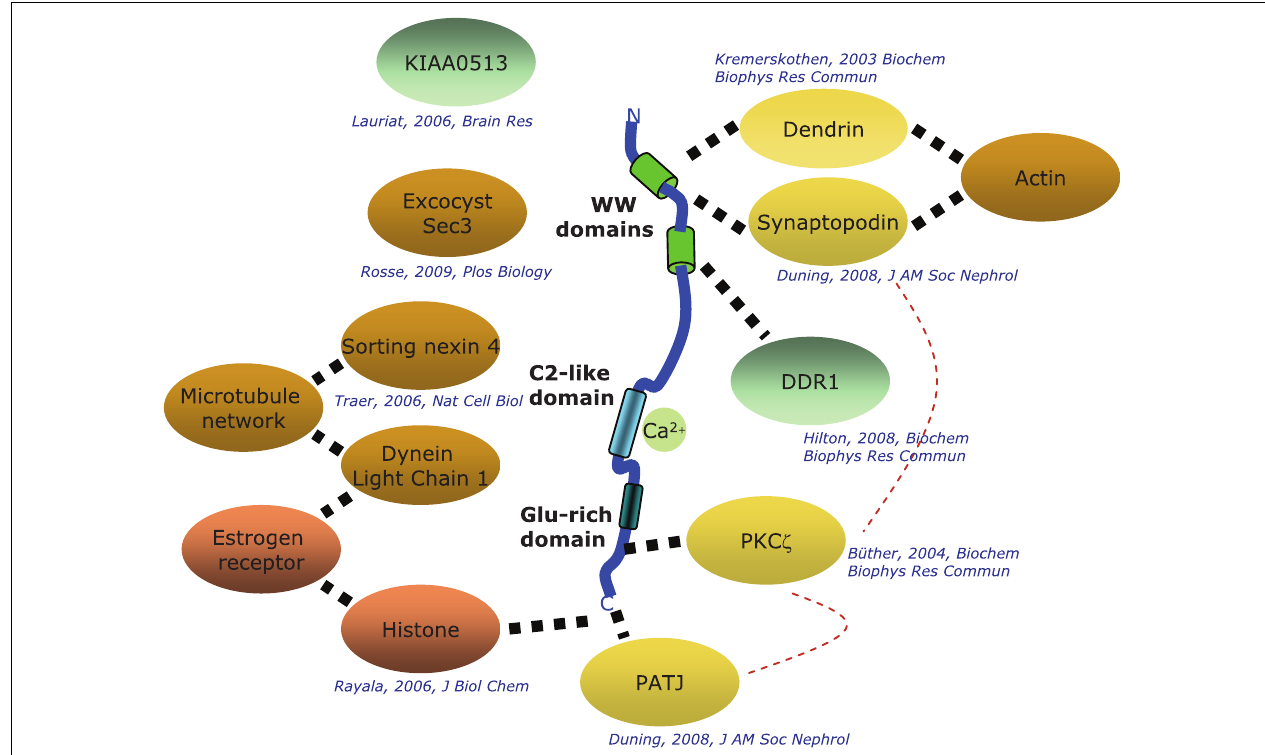
FIGURE 2 | Known interactors of KIBRA. Depicted are interaction partners of KIBRA identifi ed by a number of laboratories with the respective citations given. Solid dotted lines: direct interactions that have been mapped to specifi c segments of the KIBRA protein; hatched broad lines: direct interactions where the location of binding is not